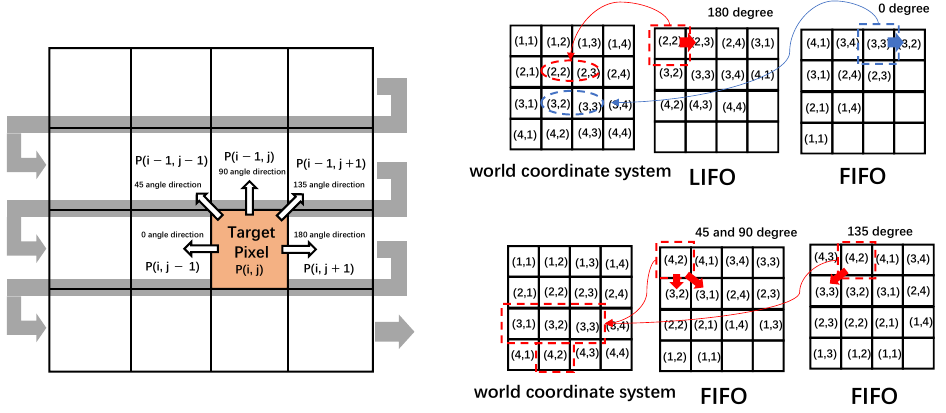
Figure 12. The direct sketch map of multi-direction occlusion filling.